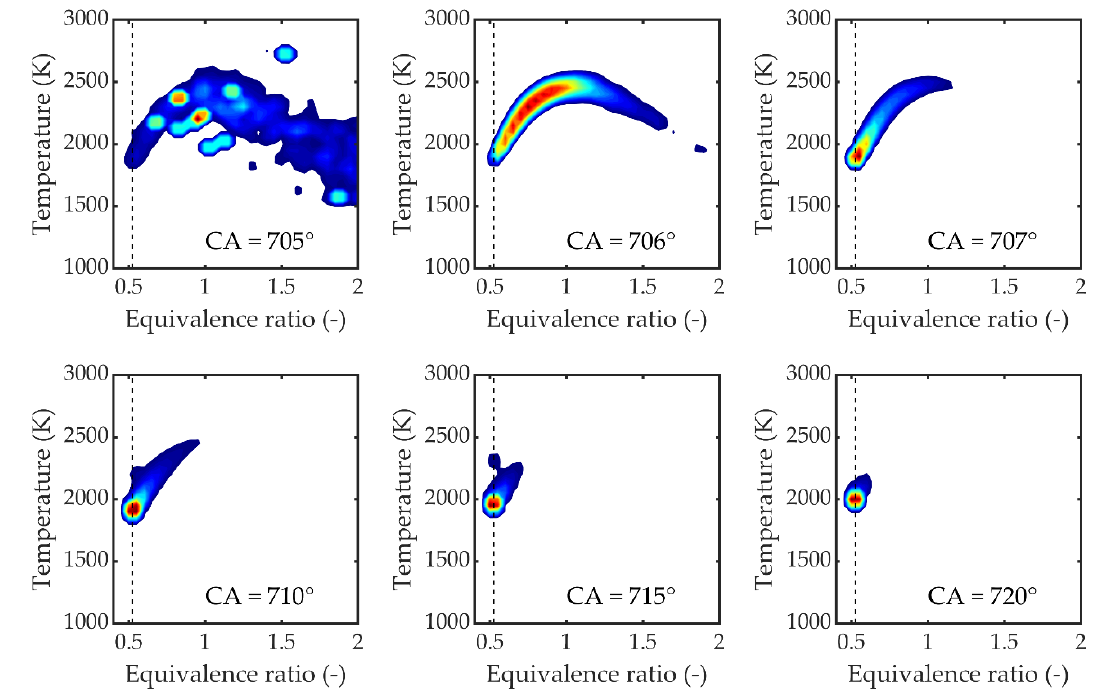
Figure 11. Volume-based probability distribution of temperature and equivalence ratio in the flame for six different crank angles.